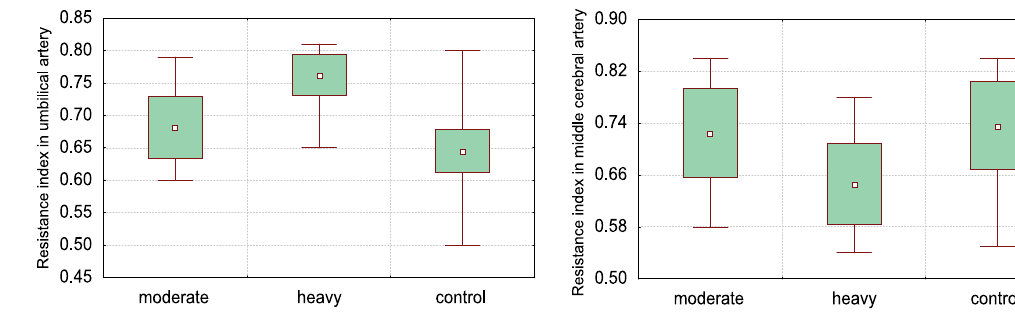
FIGURe 2. Mean values, standard deviations, and upper and lower values of resistance index in middle cerebral artery in moderate, heavy and non-smokers (control) groups of preg- nant